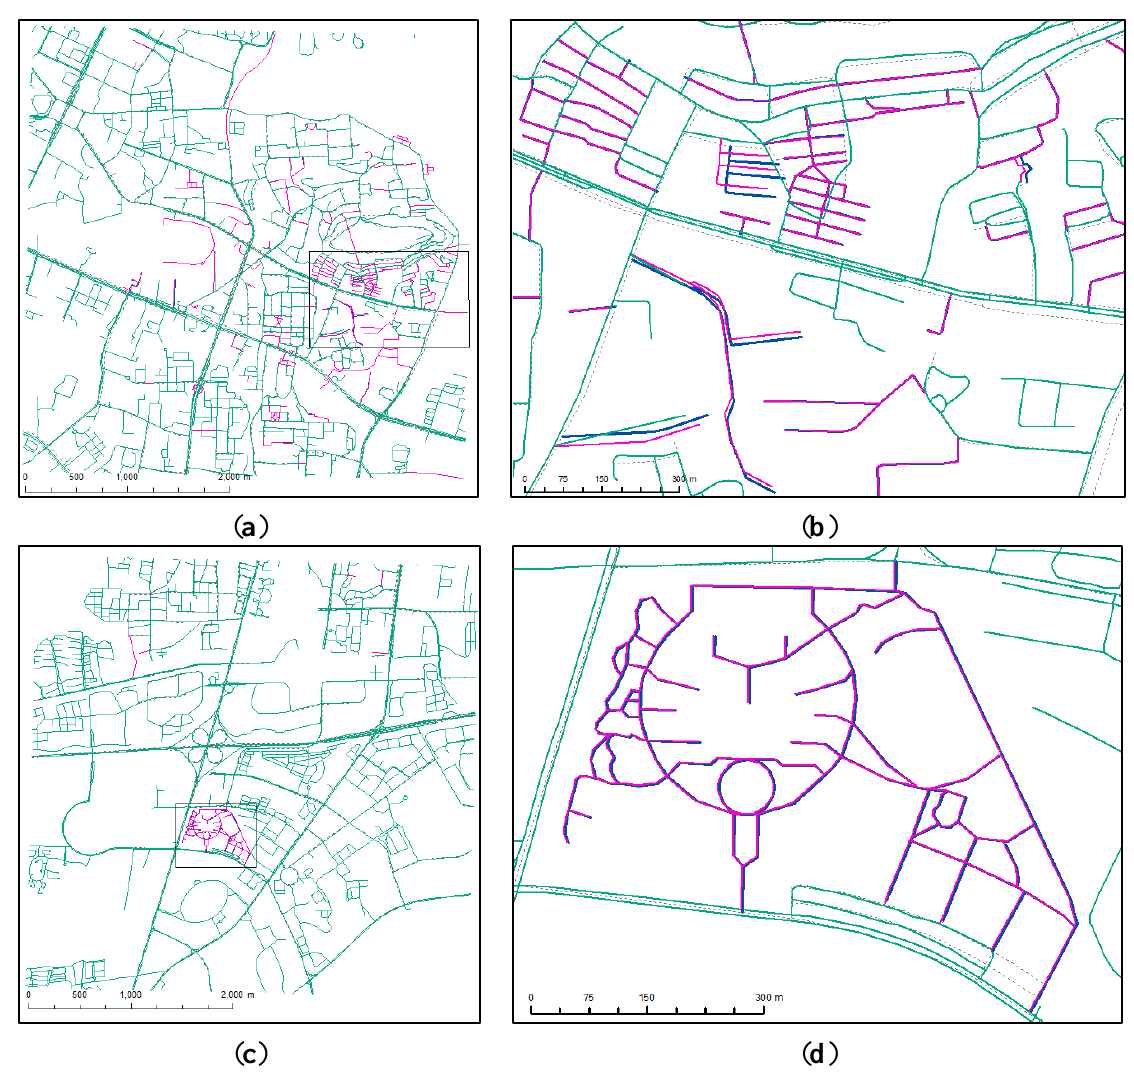
Figure 11. New roads added to the reference roads of subset 3 ( a,b ) and subset 5 ( c,d ). The right Figures b and d are an enlarged version of the boxed areas in the left Figures a and c, respectively. Reference roads are shown in green, new roads in blue, the merged new roads in pink, OSM roads in dotted